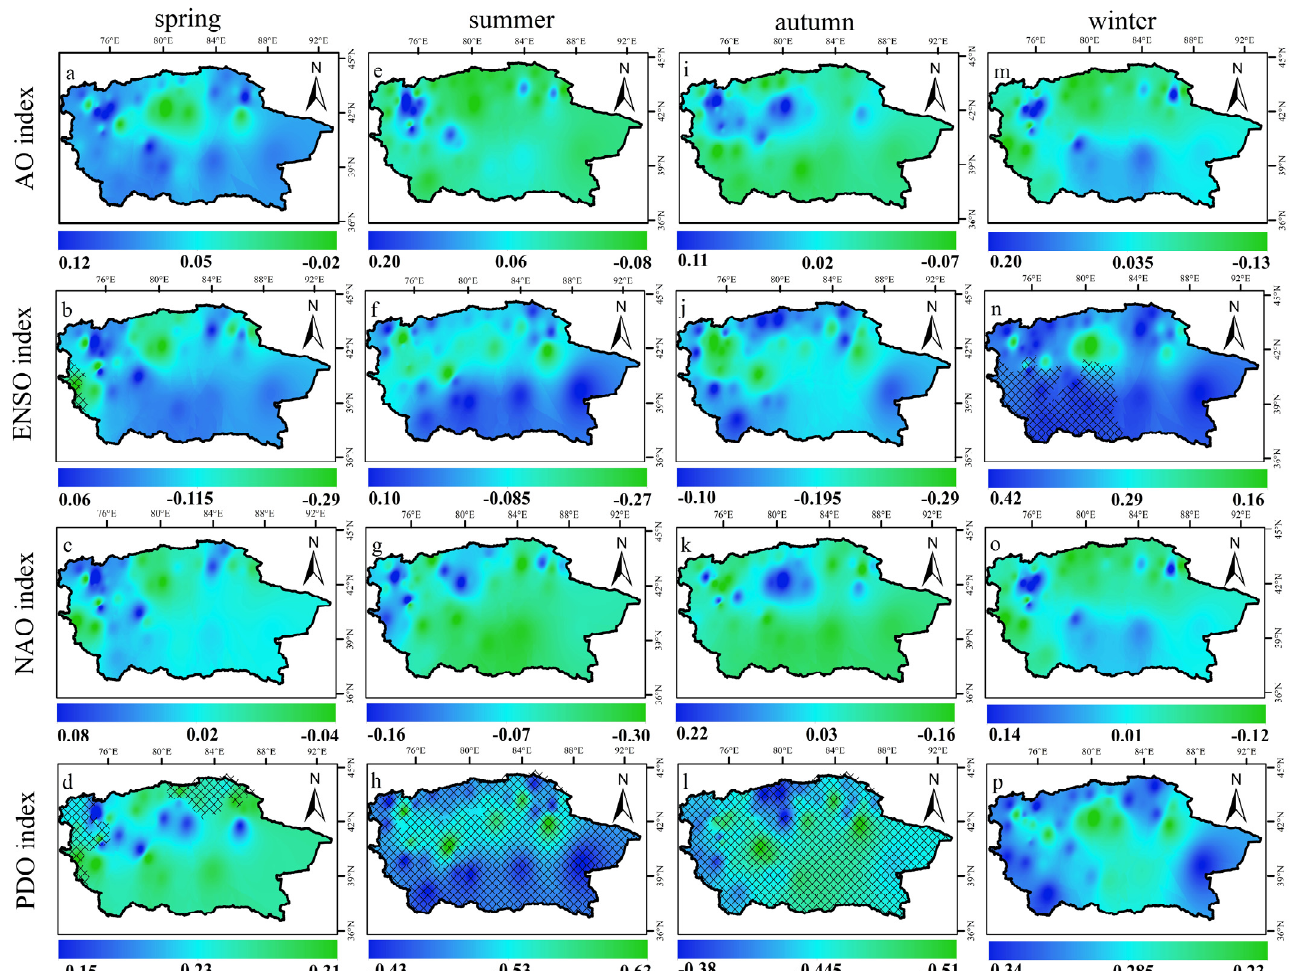
Figure 5. Spatial distribution of the correlation between average annual temperature and atmospheric circulation in the Tarim Basin. Each column corresponds to a season, and each row corresponds to an atmospheric circulation index (the black bars on the grid indicate that the trends are statistically significant at the 0.05 level).